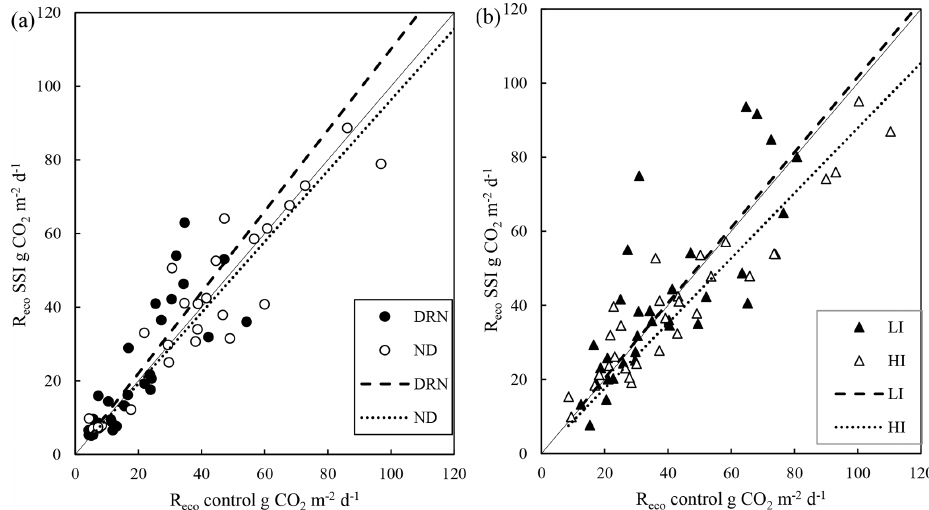
Figure 6. Measured fluxes for ecosystem respiration ( R eco ), one-to-one comparison in which daily averages were used. (a) Values are divided into two groups: with lowered groundwater table due to the effect of drainage (DRN) and with a small difference (ND). (b) Values are divided into two groups with irrigation effects: moderate infiltration with more than 5–20cm difference (LI) and high infiltration (HI) with more than 20cm difference between SSI and control. The black filled line is the 1 : 1